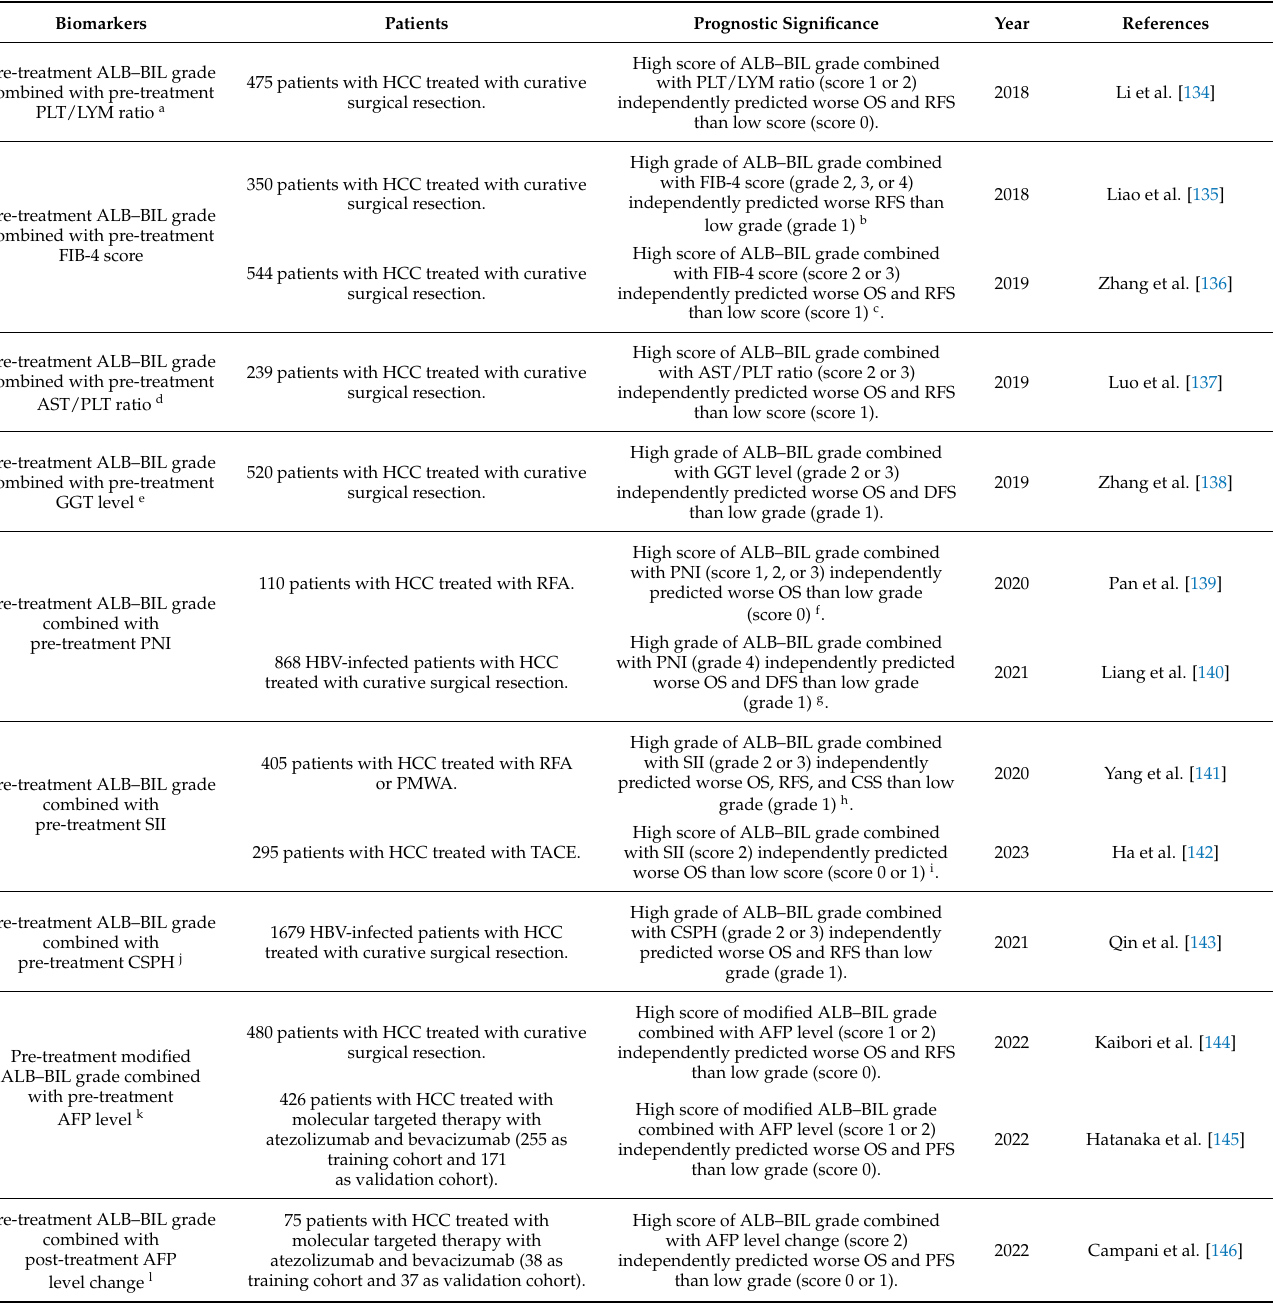
Table 8. Prognostic significance of serum ALB-based combination biomarkers in HCC